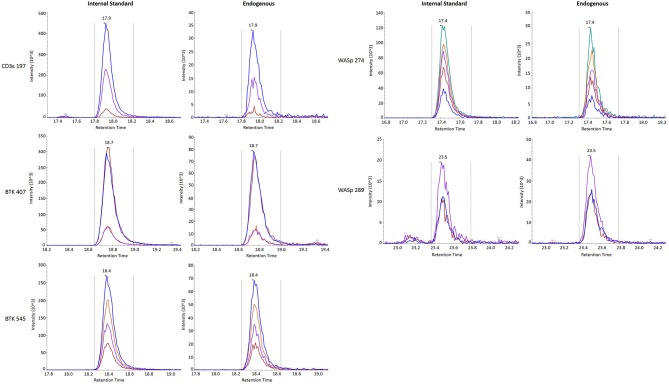
SRM traces for internal standard (Left) and endogenous (Right) signature peptides.